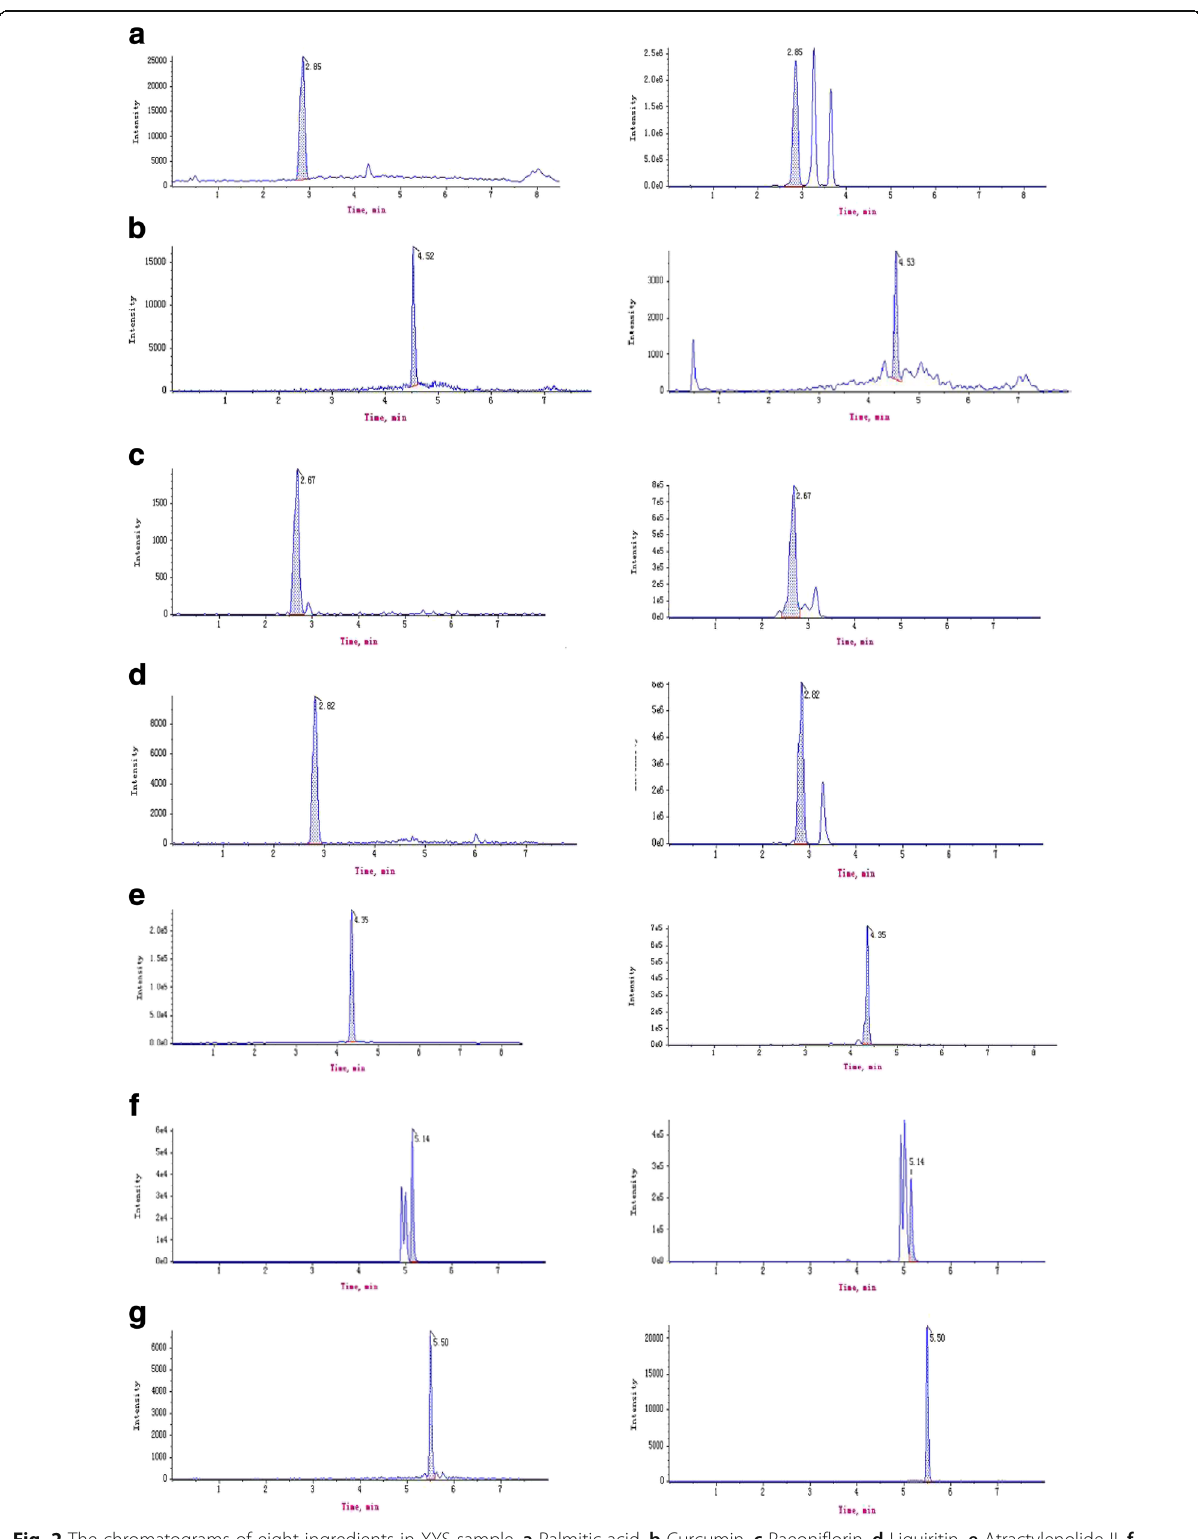
Fig. 2 The chromatograms of eight ingredients in XYS sample. a Palmitic acid. b Curcumin. c Paeoniflorin. d Liquiritin. e Atractylenolide II. f Saikosaponin D + SaikosaponinB1. g Pachymic acid. References results are shown on the left side, and results on samples are shown on the right